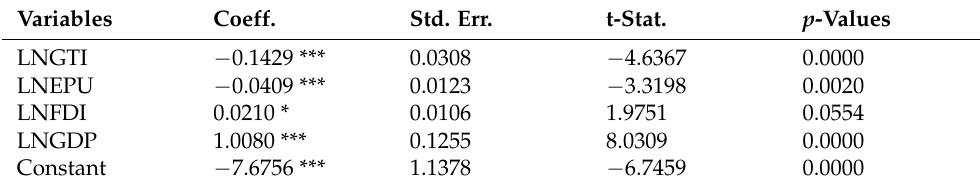
Table 15. Fully modified ordinary least square.